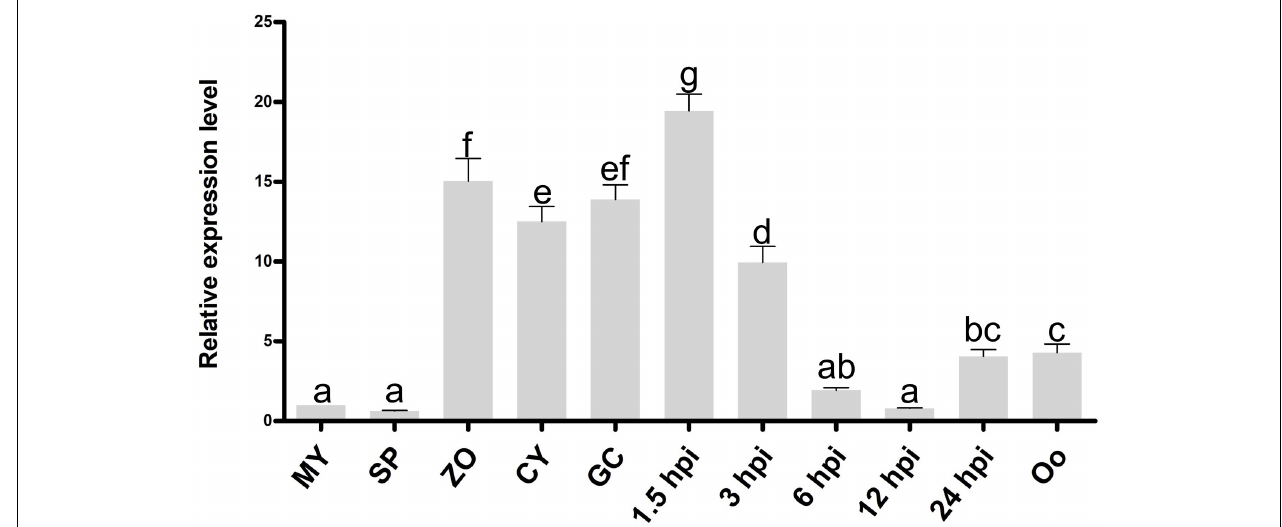
FIGURE 2 | Expression pattern of PlCB5L1 during the sexual, asexual and infection stages of P . litchii . Expression levels were determined by qRT-PCR using RNAs extracted from vegetative mycelia (MY), sporangia (SP), zoospores (ZO), cysts (CY), germinated cysts (GC), oospores (Oo), and samples from 1.5, 3, 6, 12, and 24 h post-inoculation with zoospores on leaves. The relative expression levels were calculated by using the MY sample as reference. Data are mean ± SD ( n = 9). The data were statistically analyzed with SPSS (version 20.0) with Duncan’s Multiple Range Test method and different letters denote statistical differences ( p < 0.05).